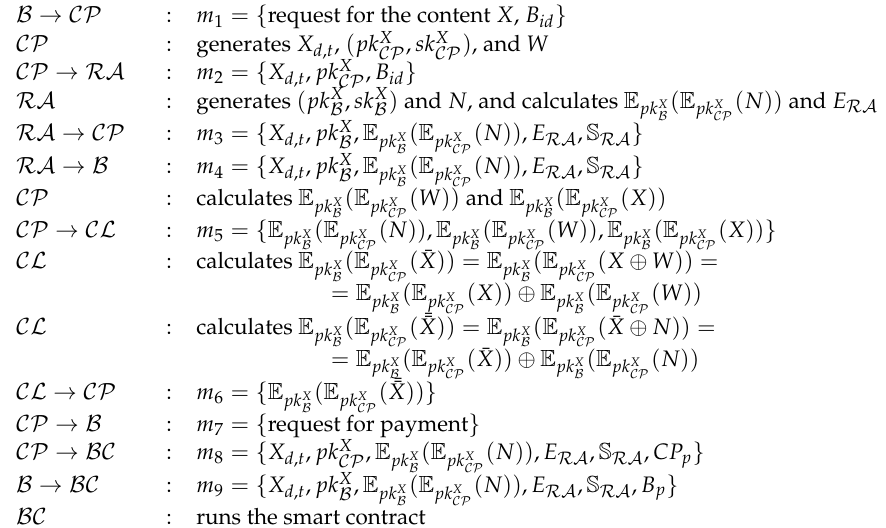
Table 3. Protection